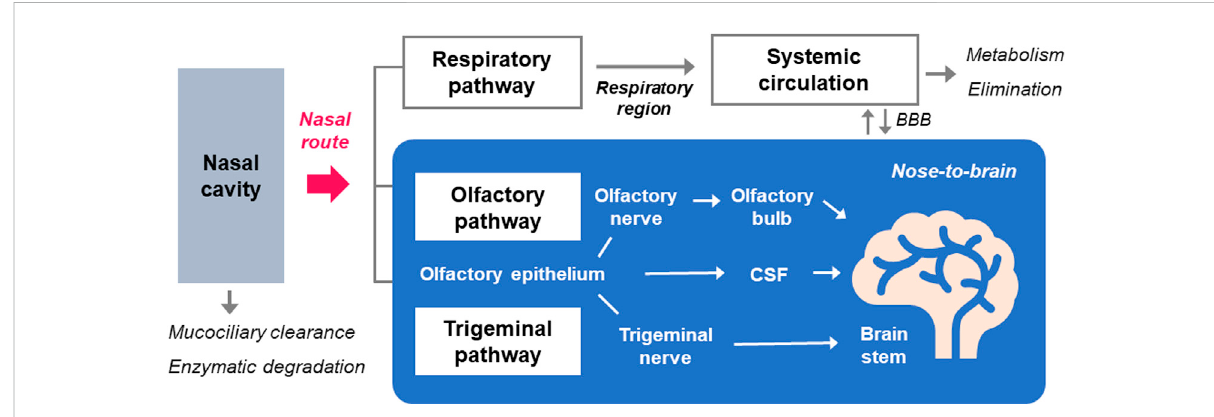
FIGURE 2 The routes for thesystemic and nose-to-brain deliveryof molecules by nasal administration. Followingthenasal administrationof drugs, some aresubjectedto mucociliary clearance andenzymatic actions inthenasal mucosabeforetheir entryinto systemicandCNScompartments.Drugsin therespiratoryregionaroundtheinferiorturbinateinthenasalcavityareabsorbedintothebloodcirculationthroughtherespiratorypathway.Nose- to-brain pathway is largely divided into olfactory and trigeminal pathways, which involve axonal transport of olfactory and trigeminal nerves, respectively.Transepithelialpermeationofdrugsacrosstheolfactoryepitheliumalsocontributestoitsdeliverytothebrainafternasaladministration, through the CSF